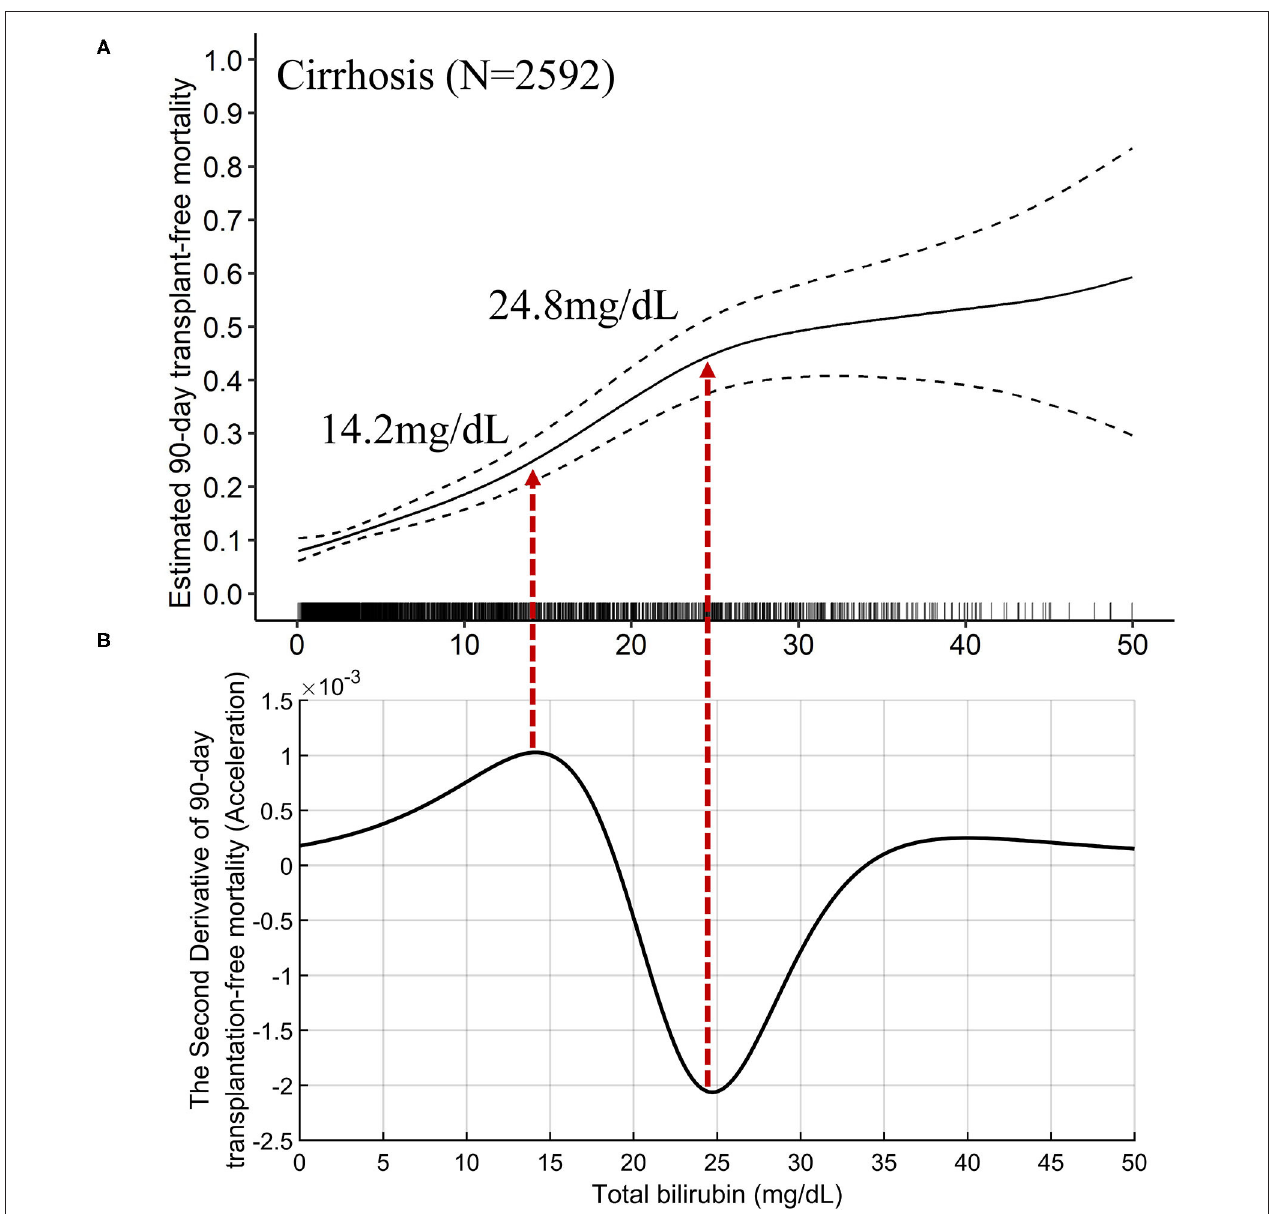
FIGURE 3 | The TB-mortality (90-day) correlation curve of cirrhosis and the corresponding second derivative (acceleration) curve. (A) the TB-mortality correlation curve of cirrhosis; (B) the second derivative (acceleration) of TB to mortality. TB, total bilirubin.